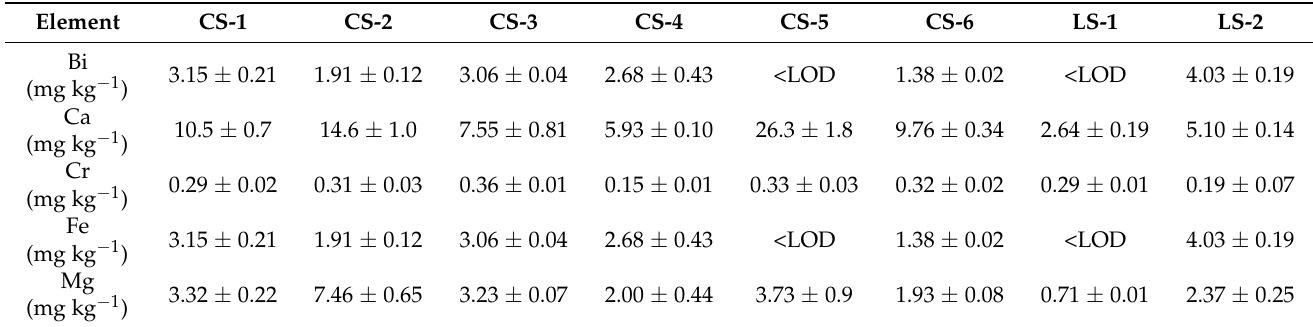
Table 7. Elemental composition of the hard candy and lollipop samples.